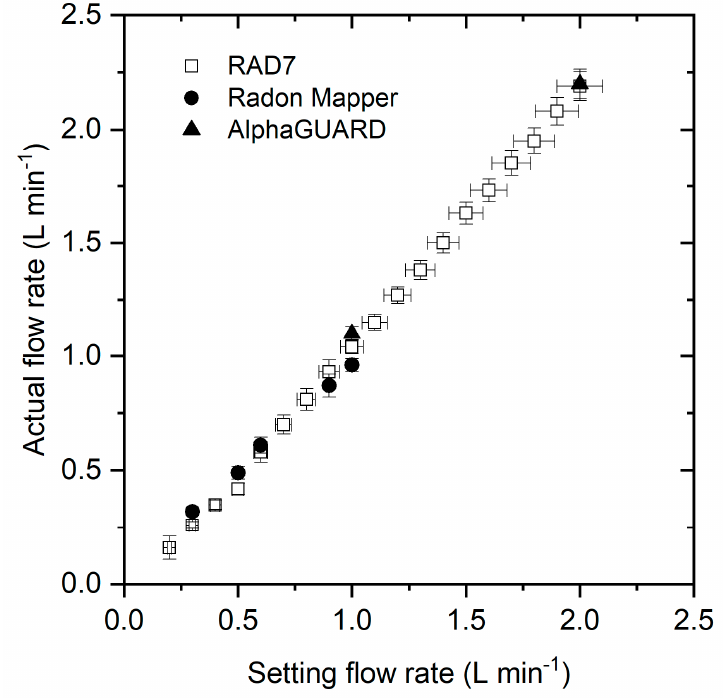
Figure 3. Relationship between the setting flow rate and actual flow rate measured by a mass flow meter.